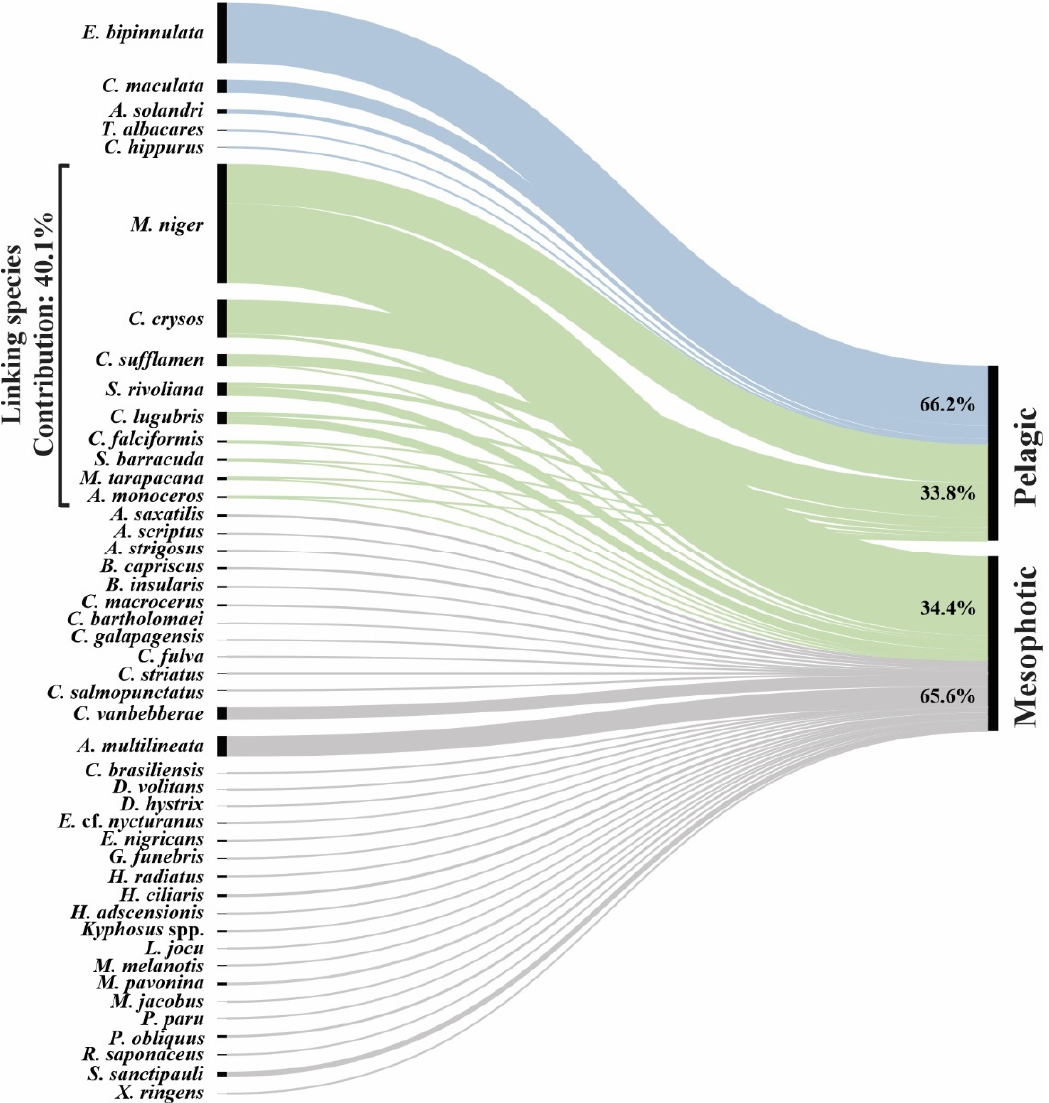
Figure 6. Alluvial plot based on the %MaxN of the species showing the contributions of the link species (green) to the pelagic (blue) and mesophotic reef (gray) fish assemblages.